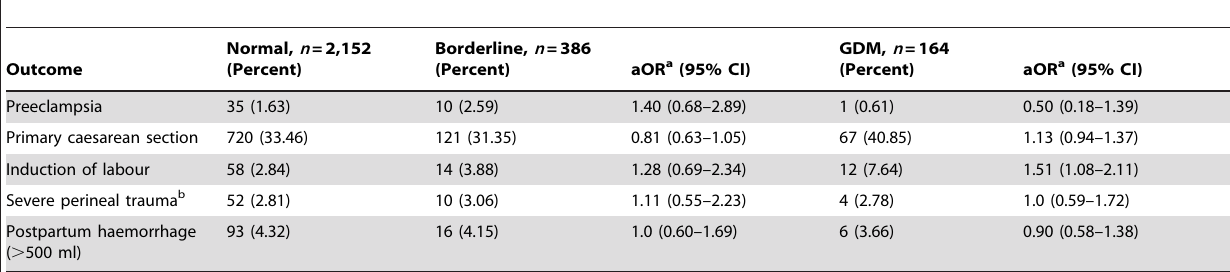
Table 4. Maternal outcomes comparing normal (referent) group to borderline and GDM groups.